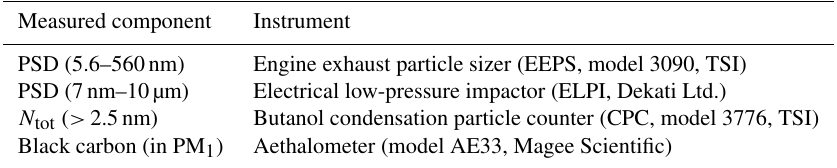
Table 1. Instrumentation of the Sniffer mobile laboratory. Abbreviations: PSD is the aerosol particle number size distribution, N tot is